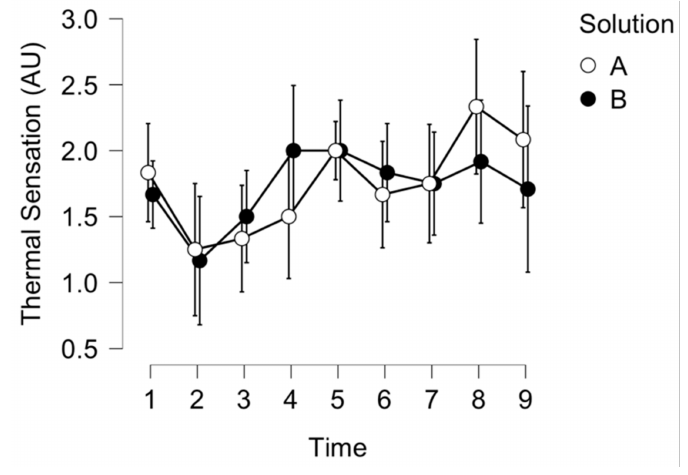
Figure 2. Participant ratings of thermal sensation following swilling solution A and B.